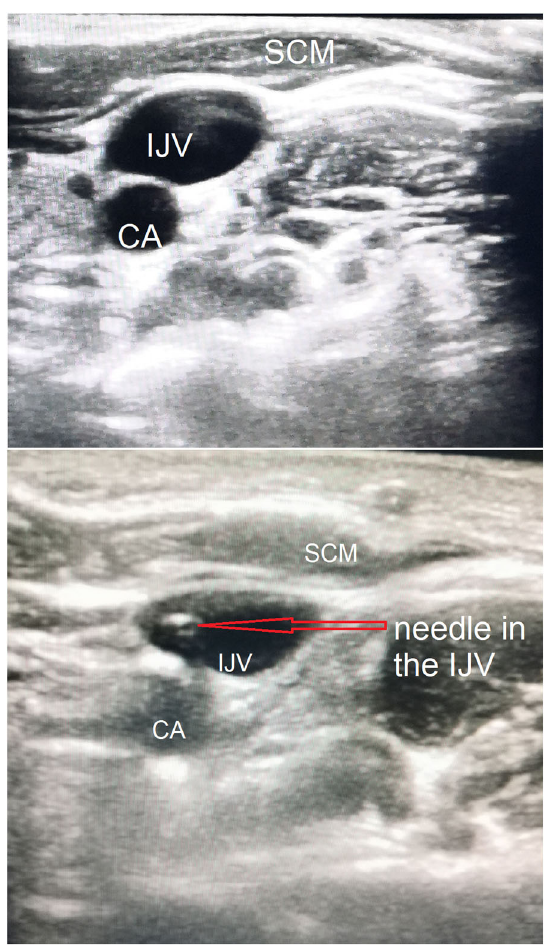
Fig. 1 Ultrasound-guided central line insertion (CA, carotid artery; IJV, internal jugular vein; SCM, sternocleidomastoid muscle). Arrow shows the needle in the